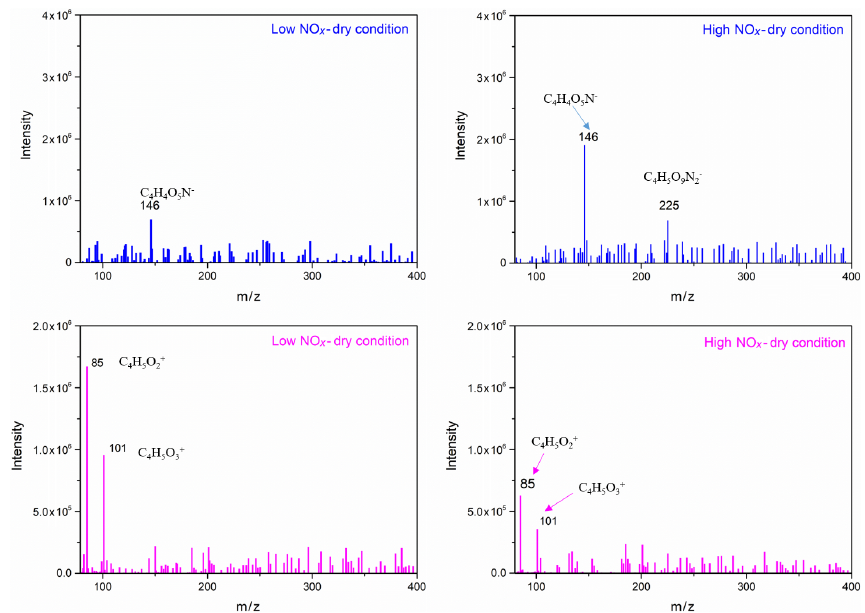
Figure 7. Selected background-subtraction HESI-Q Exactive-Orbitrap MS results of SOA in both negative (blue) and positive (pink) ion modes from the photooxidation of furan under different RH conditions.